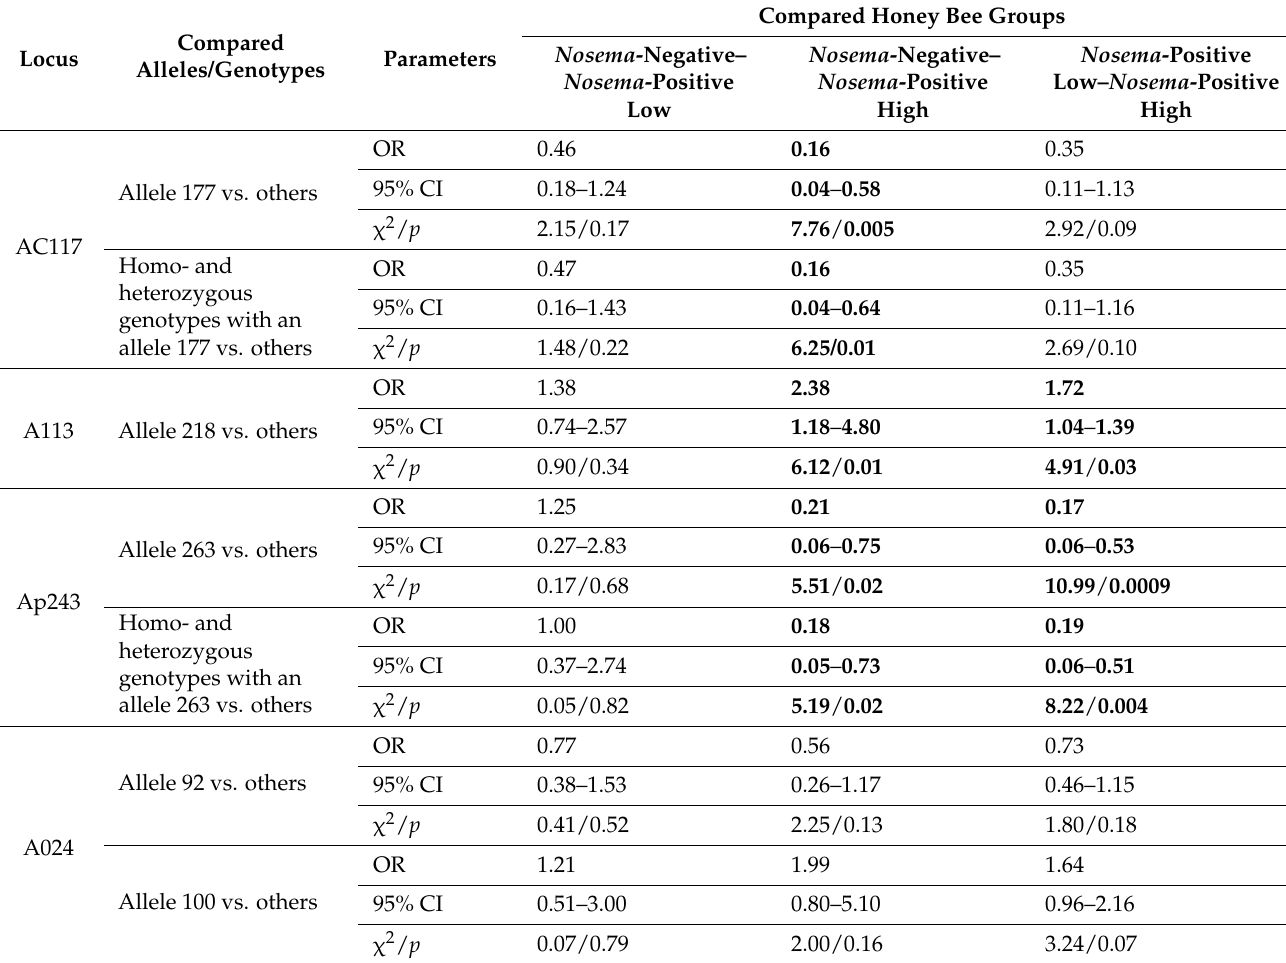
Table 2. Comparative analysis of the frequency of potentially significant genetic variants in the formation of nosemosis resistance in the dark forest bee A. m. mellifera